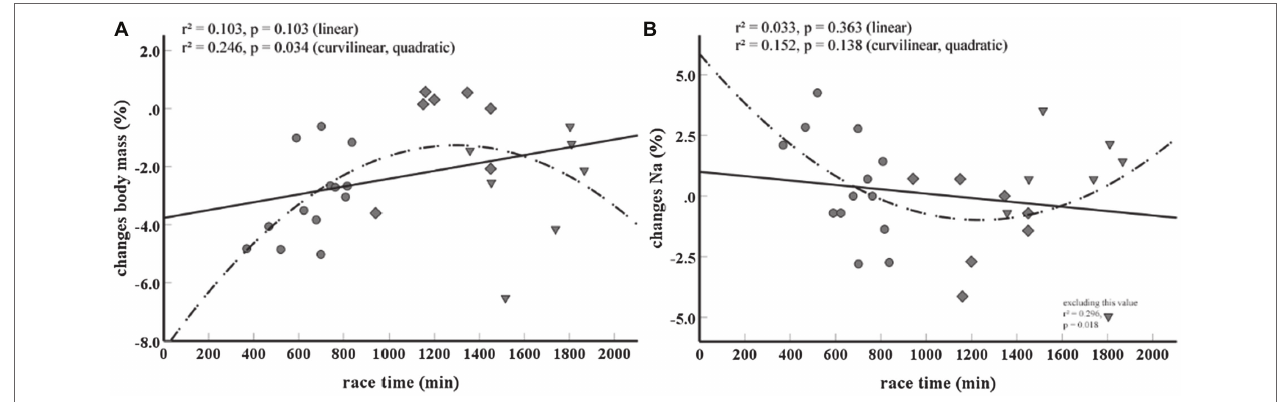
FIGURE 2 | Curvilinear (quadratic) relationship between (A) race time and percent changes in body mass and (B) race time and percent changes in serum sodium concentration. At the bottom right, Figure 1B shows the outcome of the analysis when excluding one outlier. Circles represent finishers of the short race, rhombus non-finishers of the long race and triangles finishers of the long race. Na, serum sodium